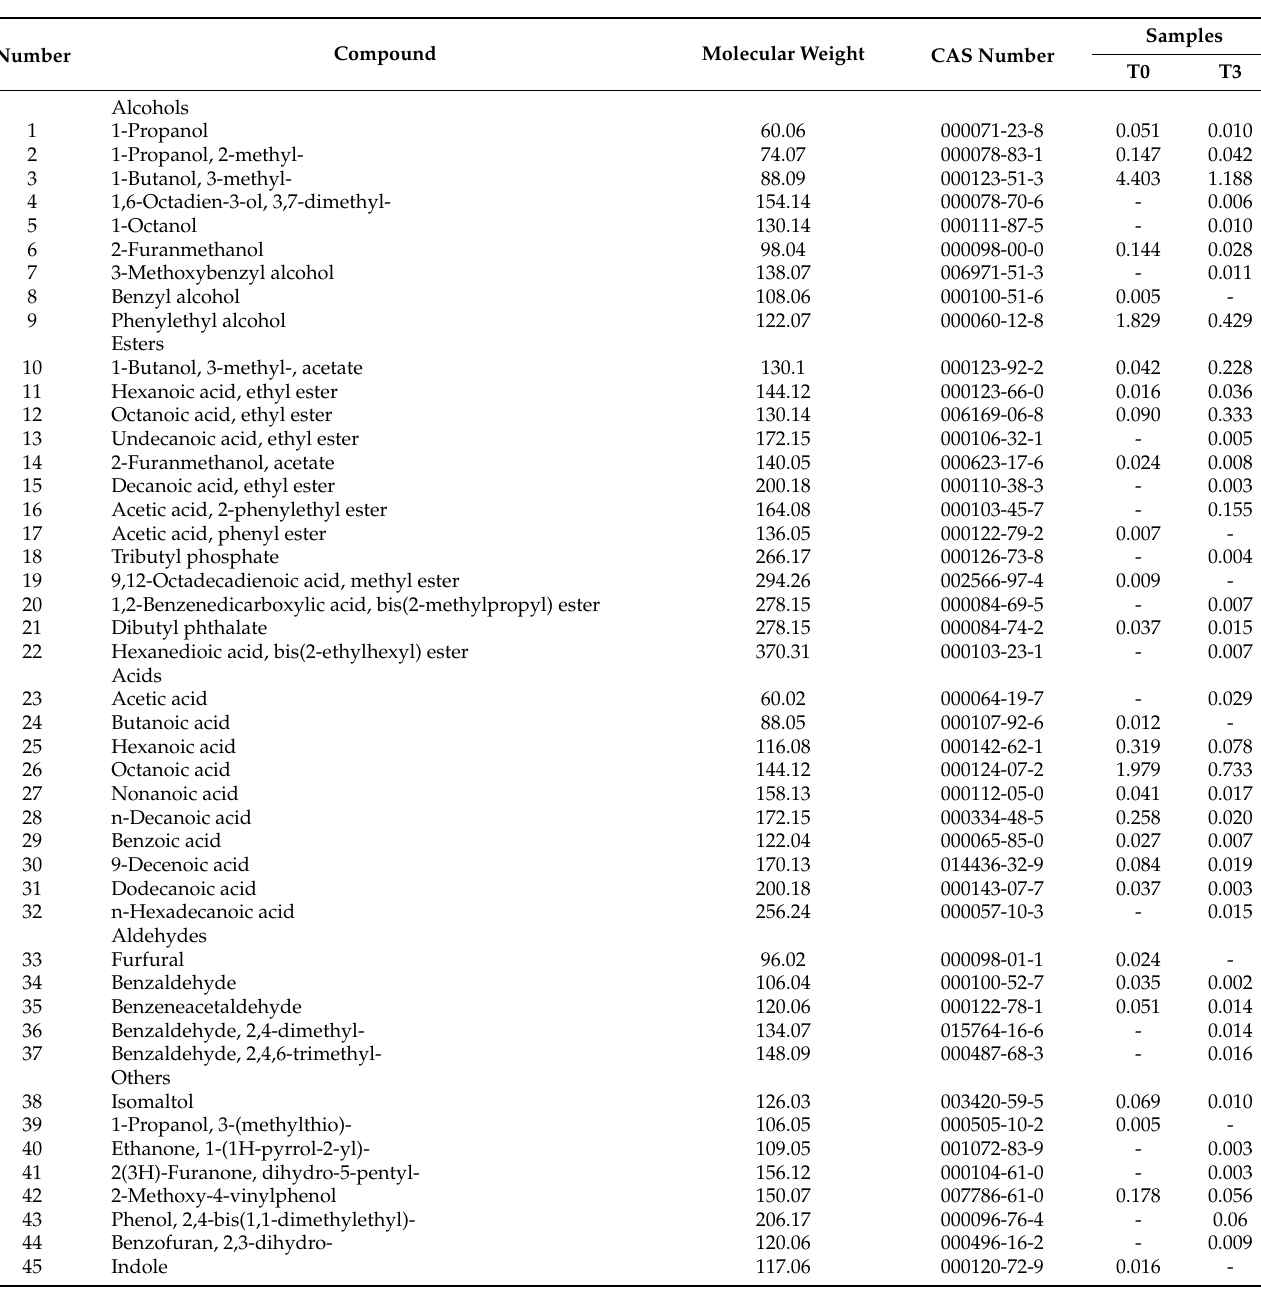
Table 2. Effects of the addition of D. officinale on the contents of individual volatile components of beer samples (mg/L)